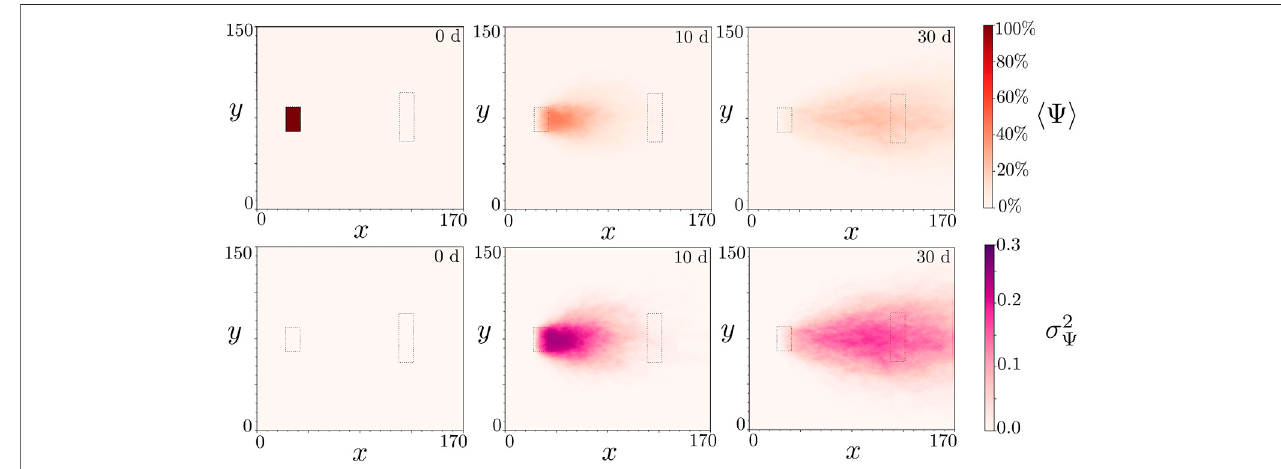
FIGURE 5 | Maps of the probability of concentration exceedance (top), and its uncertainty (bottom) at different instant of time in the simulation (columns). Plots of thetoprowshowshow 〈 Ψ 〉 [-]evolvesinspacerespectivelyafter 0,10and30 days fromthebeginningofthecontamination process. 〈 Ψ 〉 isexpressedasaprobability, as indicated by its values on the color bar on the right. The bottom row shows σ 2 Ψ , as a measure of the uncertainty related to the information given by the plots in the row above.